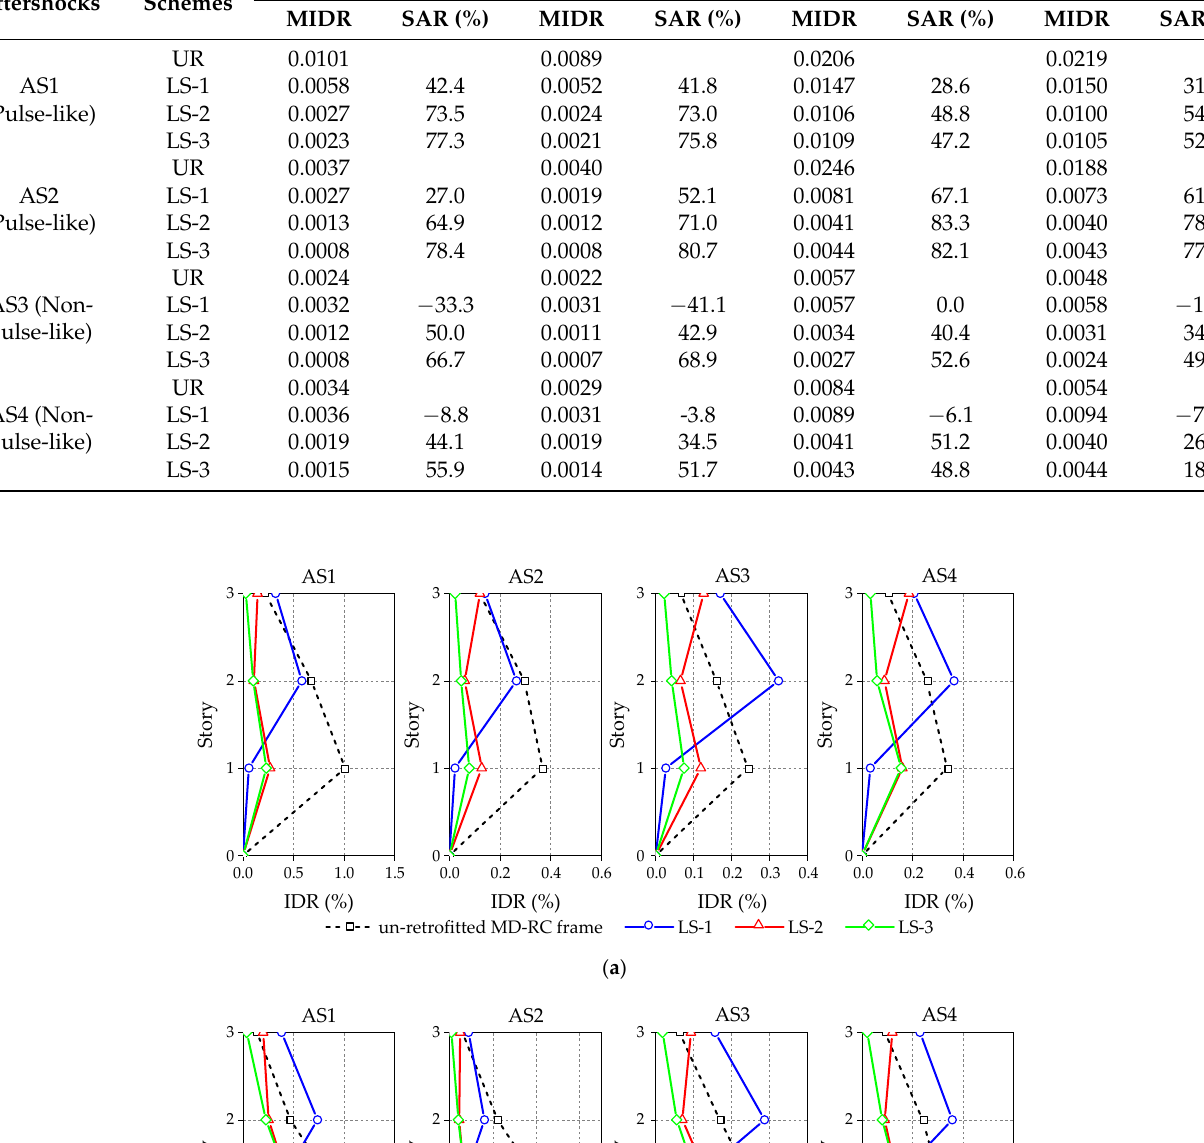
Table 8. Maximum IDR and shock absorption rate (SAR) of MD-RC frame before and after retrofitting. Aftershocks